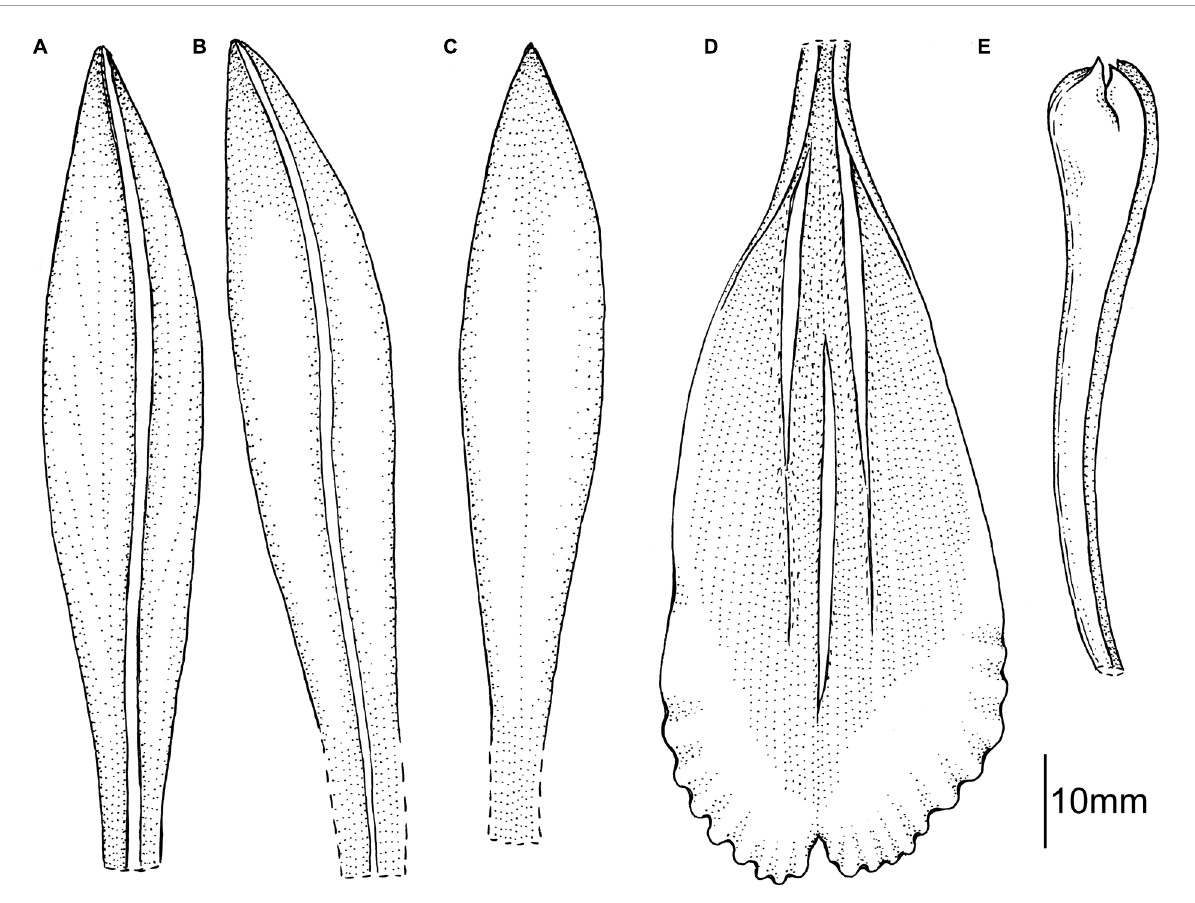
FIGURE12 Sobralia splendida Schltr. (A) dorsal sepal, (B) lateral sepal, (C) petal, (D) lip, and (E) gynostemium, side view [redrawn by A. Król from Schlechter (1929)].